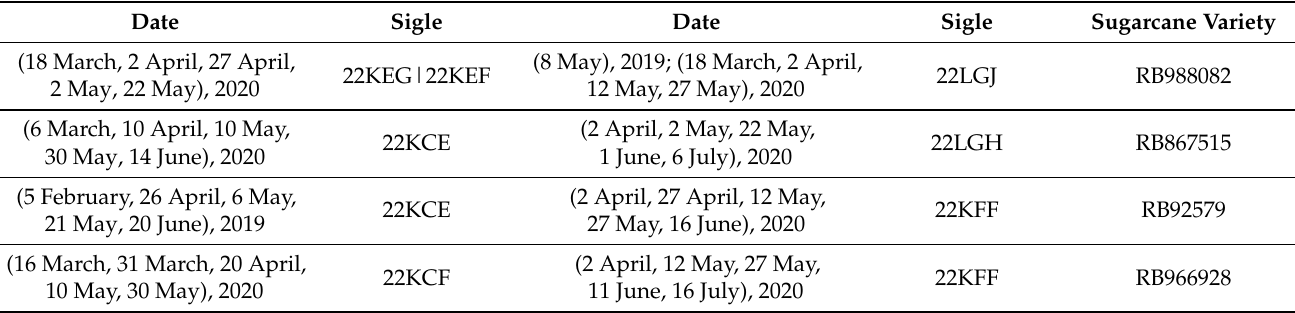
Table 1. Collection dates for the